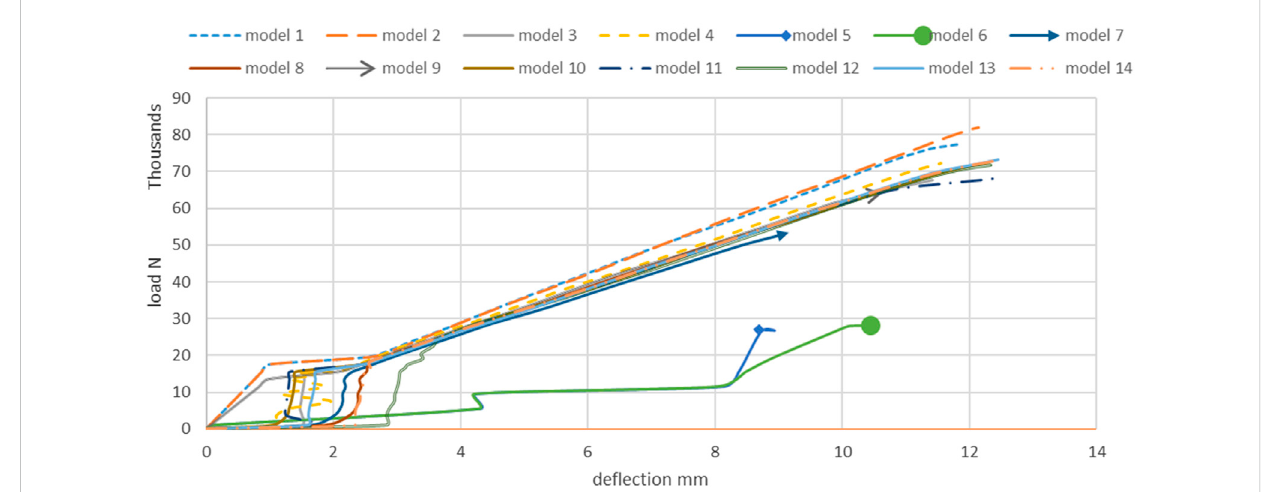
Load and de fl ection for the beam of the model by ANSYS.